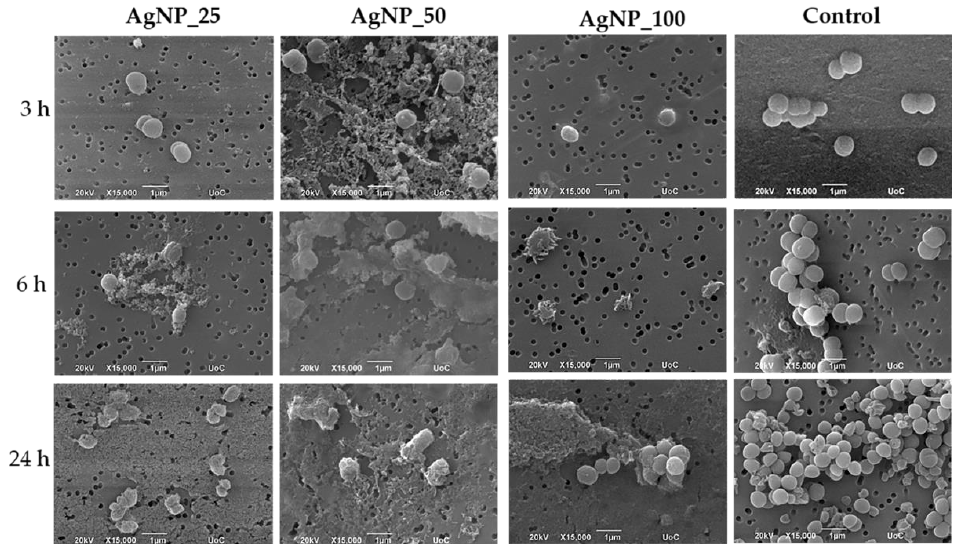
Figure 5. Representative SEM images showing the induction of 100 ppm AgNPs on S. epidermidis for 3, 6, and 24 h. The control represents the morphology of the bacteria without AgNPs. Magnification is 15,000× and scale bar represents 1 μ m.